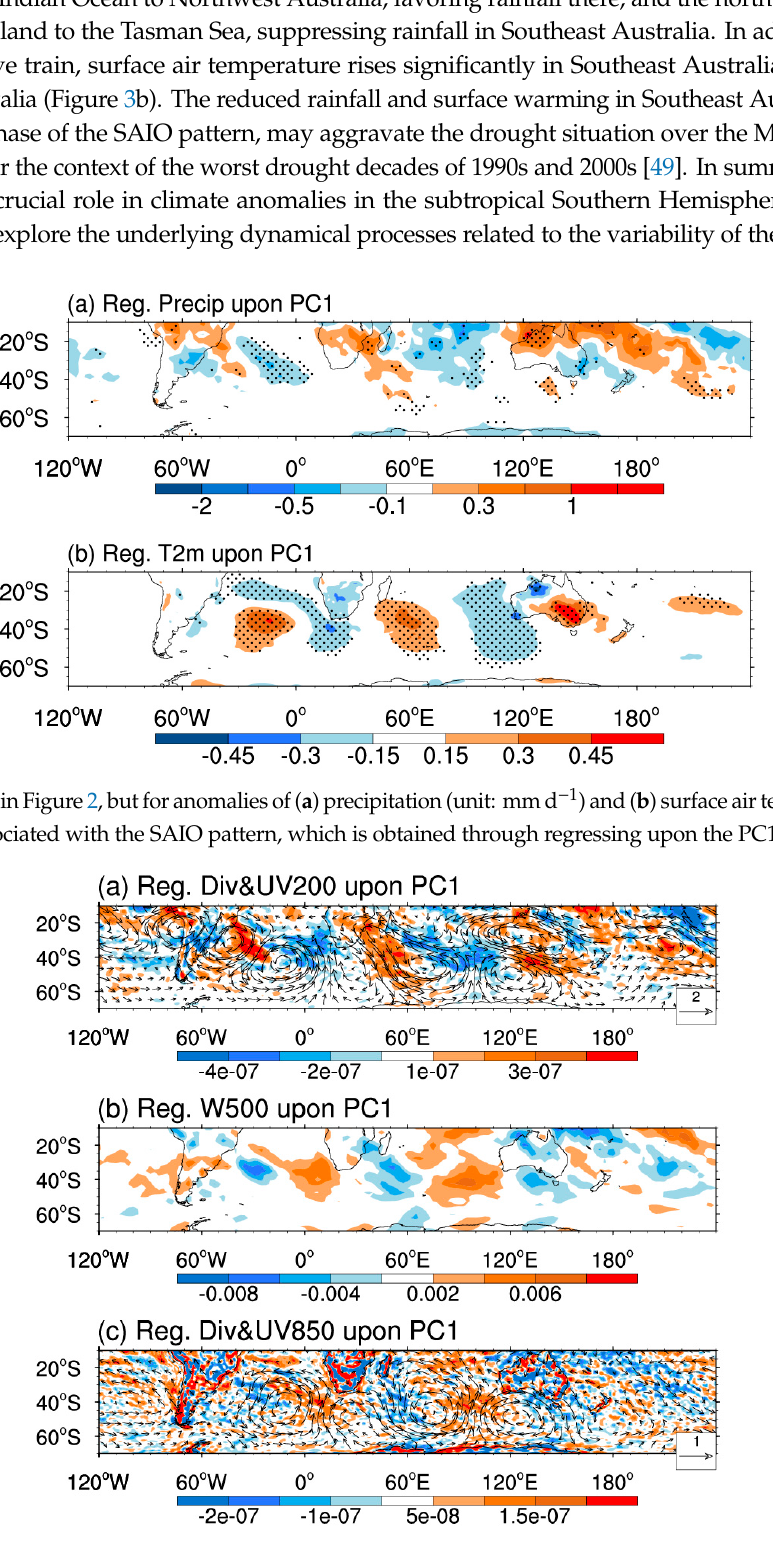
Figure 4. Anomalies of horizontal winds (vector, m s − 1 ) and its divergence (shading, s − 1 ) at ( a ) 200 hPa and ( c ) 850 hPa, and ( b ) pressure vertical velocity at 500 hPa (Pa s − 1 ) associated with the SAIO pattern.